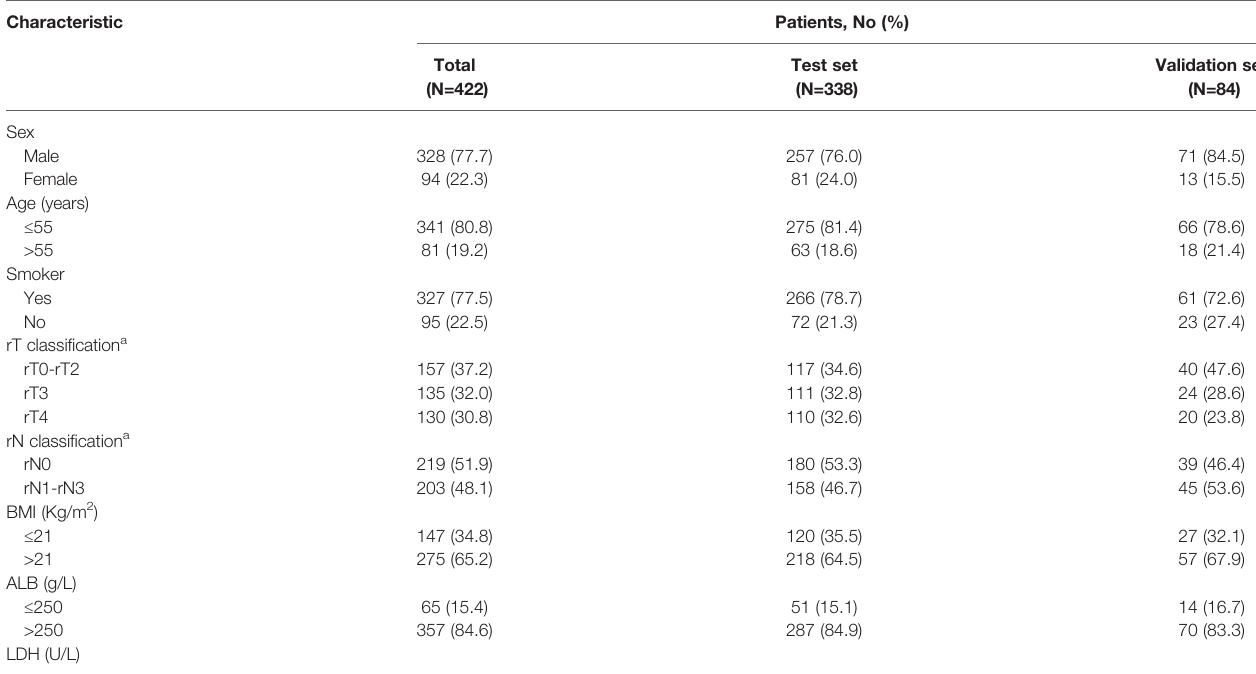
TABLE 1 | Baseline characteristics of